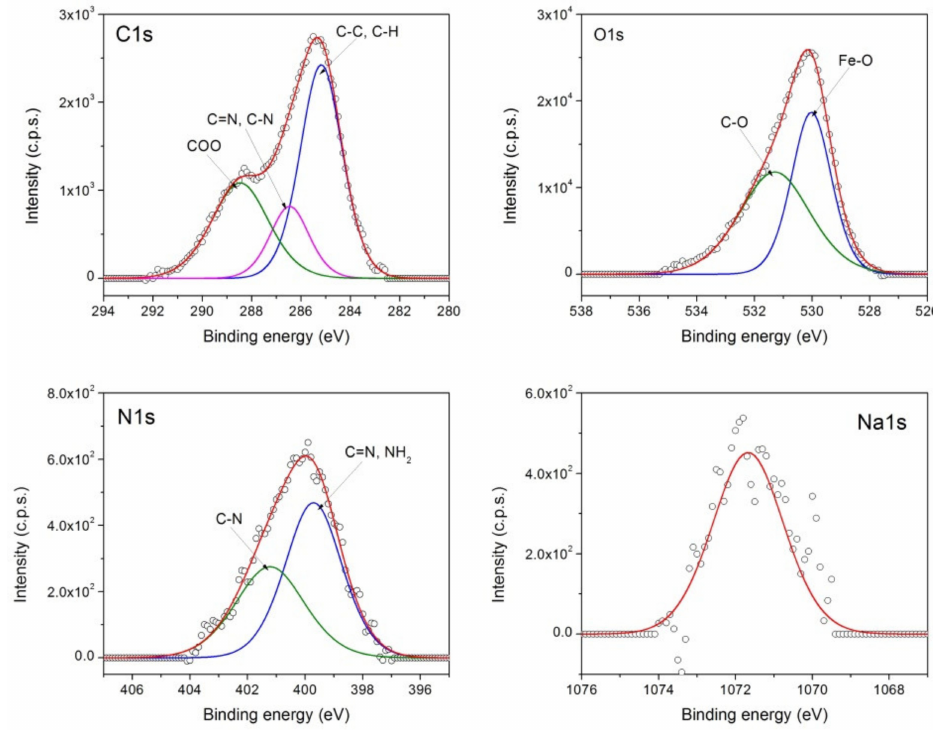
Figure 9. High-resolution XPS spectra of C1s, O1s, N1s and Na1s core-levels for MNP-AIm_2.